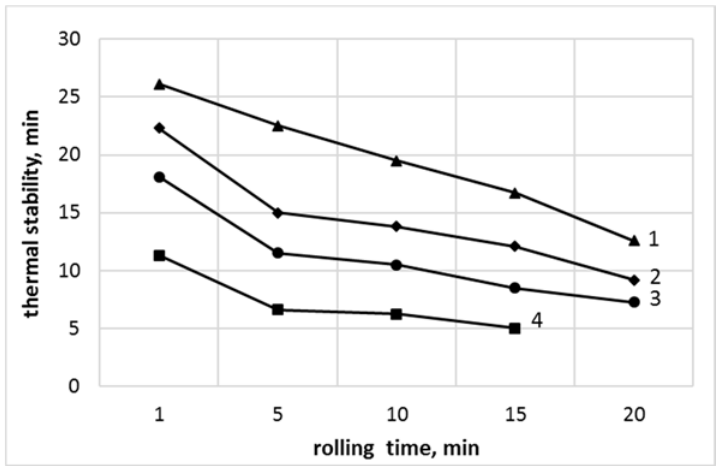
Figure 6. Congo red thermal stability of PVC and nanocomposites with SiO 2 as a function of rolling time: (1) PVC R /SiO 2 ; (2) PVC R ; (3) PVC C /SiO 2 , and (4) PVC C .